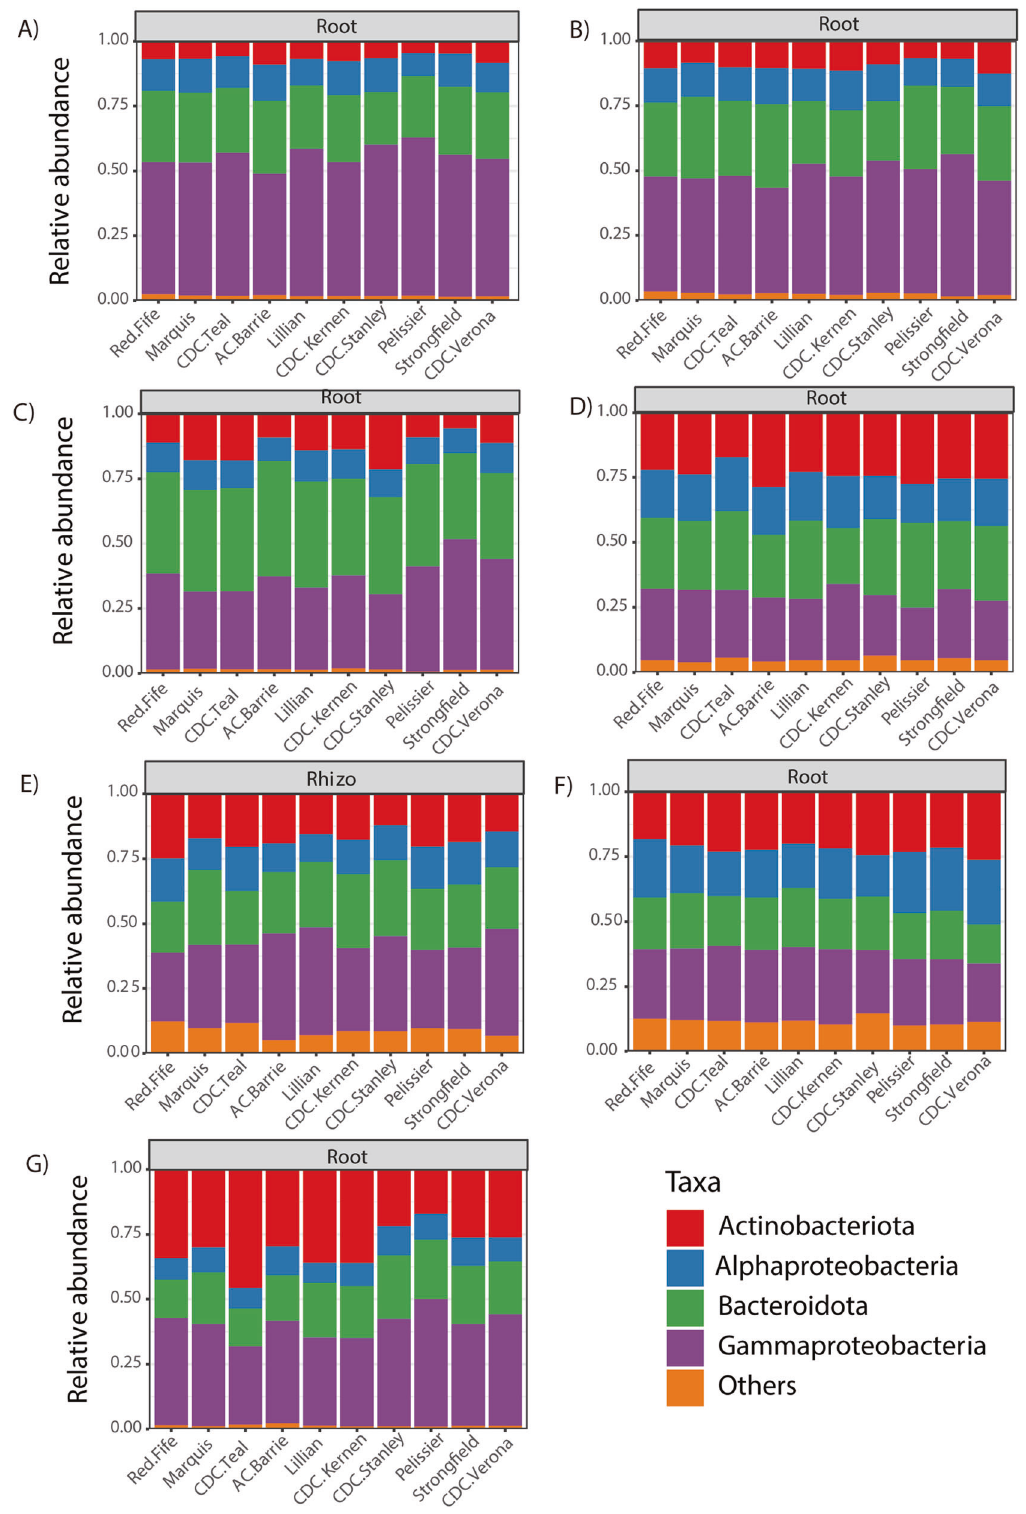
Fig. 2 Community composition of the most abundant phylum/class based on the 16 S rRNA gene amplicons for the growth stage/ compartment combinations that showed a signi fi cant ( P < 0.10) effect of genotypes in Table 3. ( A ) 2013, roots, stem elongation; ( B ) 2013, roots, dough development; ( C ) 2014, roots, stem elongation; ( D ) 2014, roots, dough development; ( E ) 2015, rhizosphere, stem elongation; ( F ) 2015, roots, dough development; ( G ) 2016, roots, stem